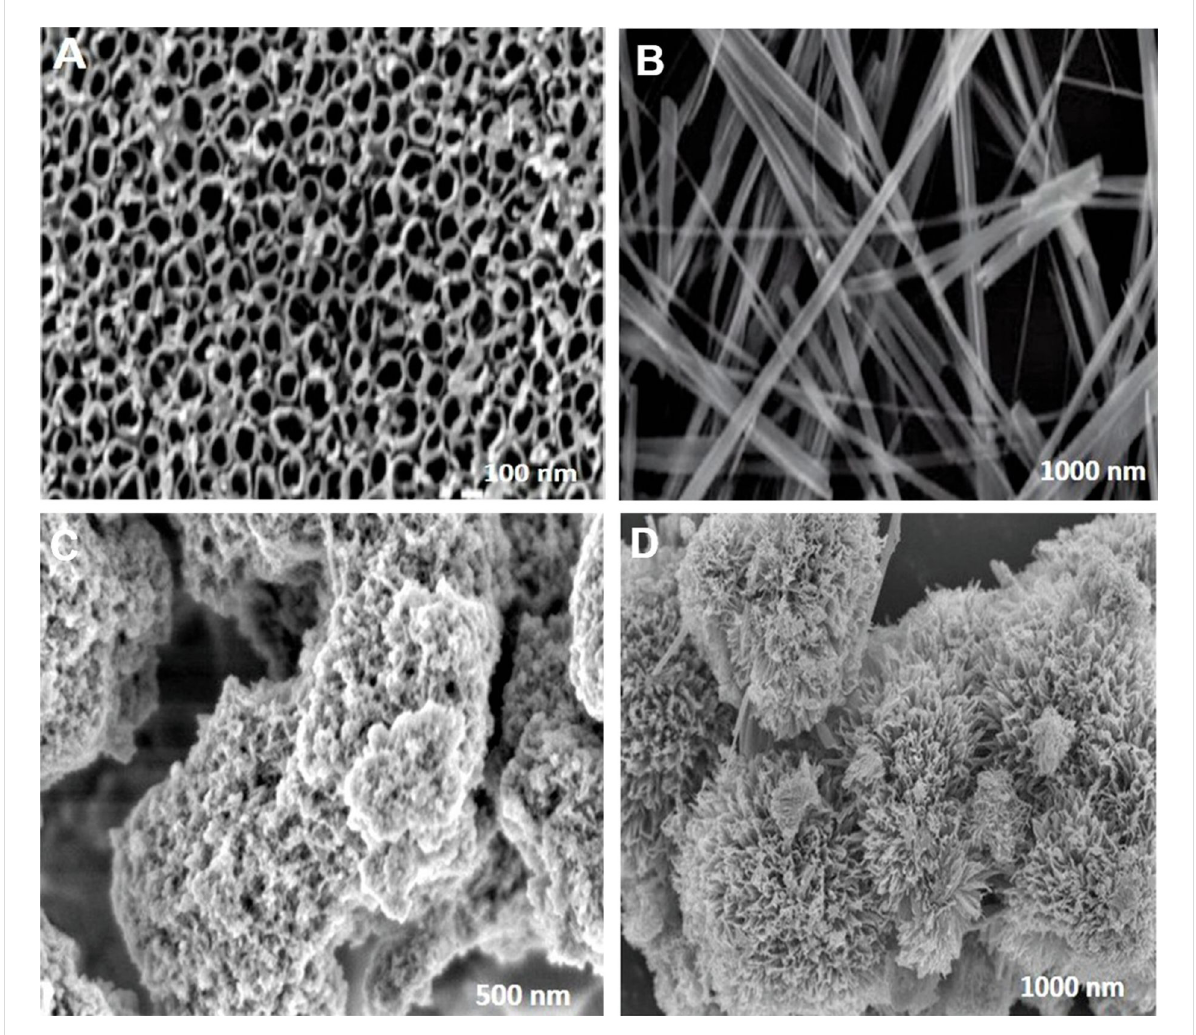
Figure 1: SEM images of titania structures. (A) Nanotubes. (Figure 1A was adapted with permission from [5], Copyright 2005 American Chemical Society. This content is not subject to CC BY 4.0.) (B) Nanobelts. (Figure 1B was adapted with permission from [6], Copyright 2010 American Chemi- cal Society. This content is not subject to CC BY 4.0.) (C) Mesostructure (unpublished image) and (D) nanoflowers. (Figure 1D was adapted with permission from [7], Copyright 2018 American Chemical Society. This content is not subject to CC BY